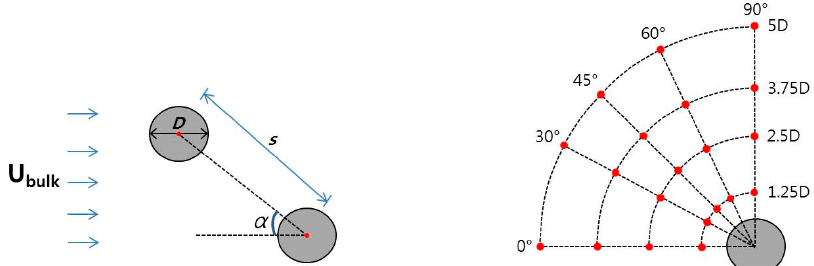
Figure 2. Schematic representation of flow around two cylinders and simulation cases with staggered array: The approaching velocity U bulk is from left to right. The α is the alignment angle between two cylinders and the dot represent the center location of another cylinder.